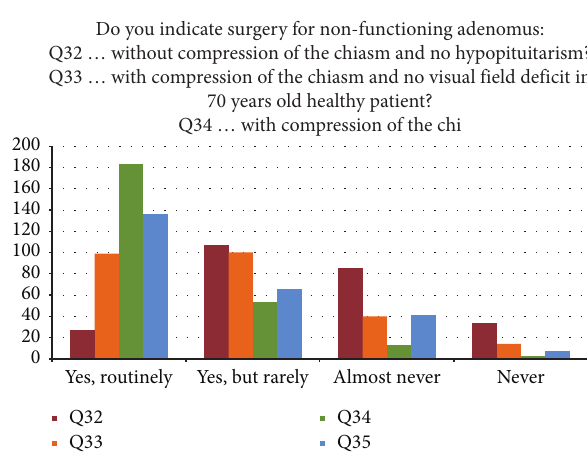
Figure 4: Different treatment strategies in nonfunctioning ade- nomas based on specific